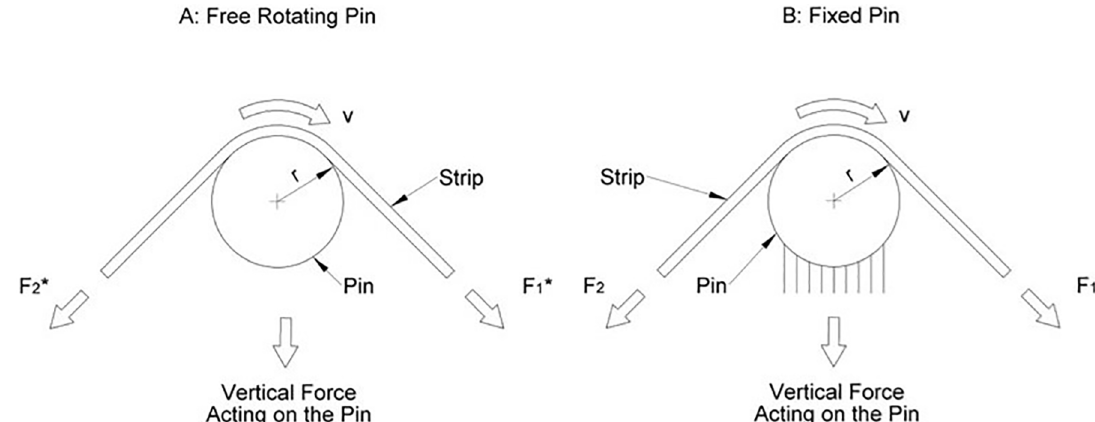
Figure 1. Schematic figure of the BUT test. Source: based on Andreasen et al.